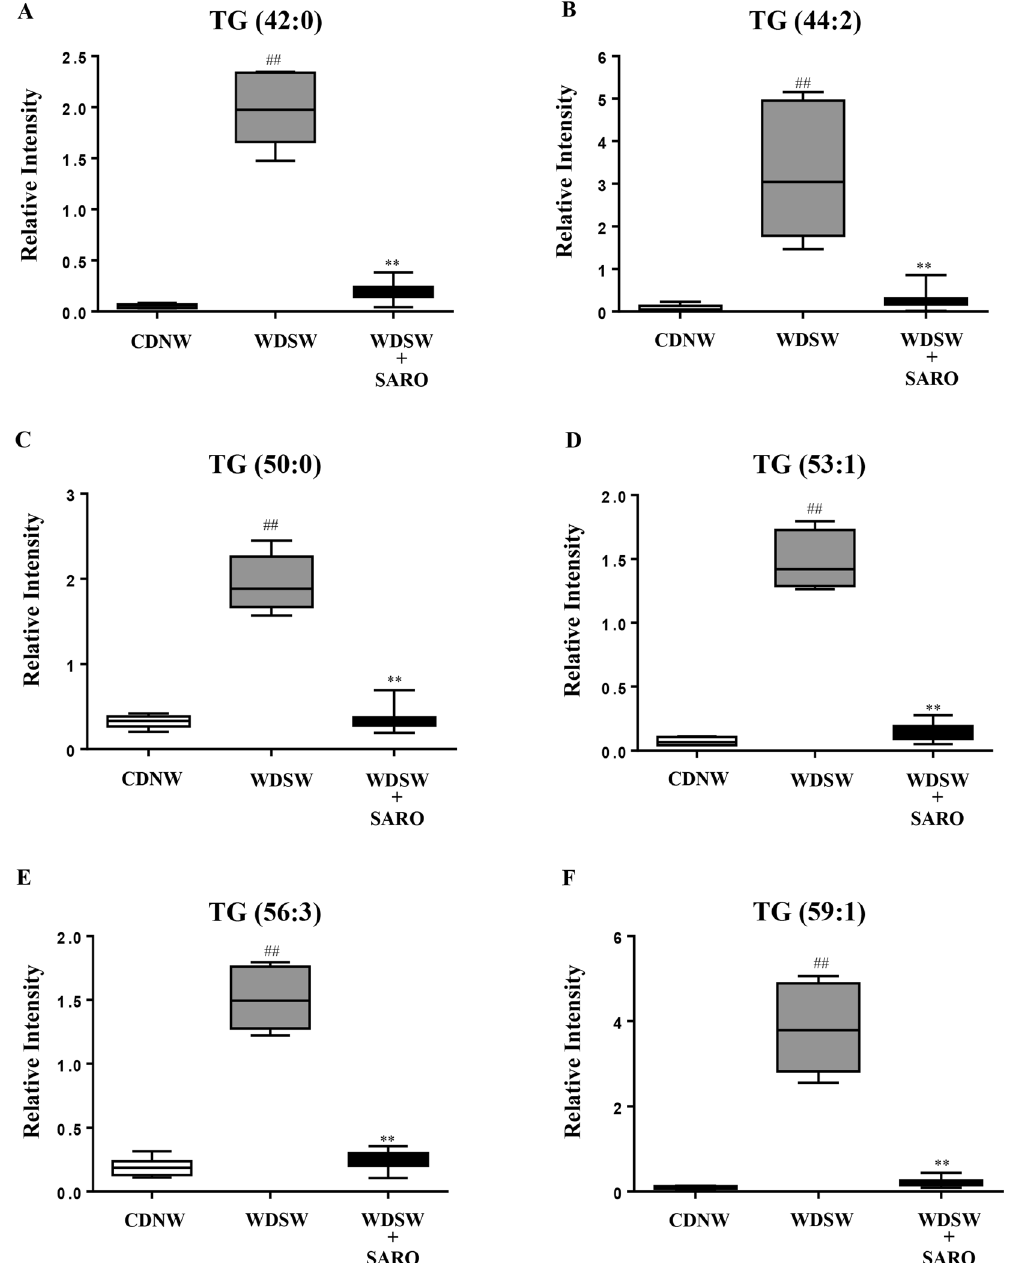
Figure 7. Saroglitazar treatment decreases triglyceride profile in DIAMOND mice. Triglyceride (TG) profiling was performed in the liver samples of mice treated/untreated with saroglitazar fed on CDNW or WDSW using ultra high performance liquid chromatography- mass spectrometry (UHPLC-MS). Box plots of ( A ) TG (42:0), ( B ) TG (44:2), ( C ) TG (50:0), ( D ) TG (53:1), ( E ) TG (56:3), and ( F ) TG (59:1). Data are expressed as the mean ± SEM for 6–12 mice per group. ## p < 0.001 compared to CDNW; ** p < 0.001 compared to WDSW, vehicle